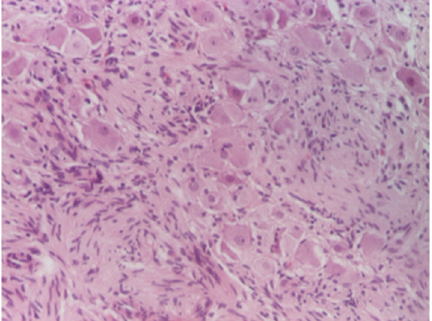
Figure 8. Scattered mature ganglion cells, HE ×100.